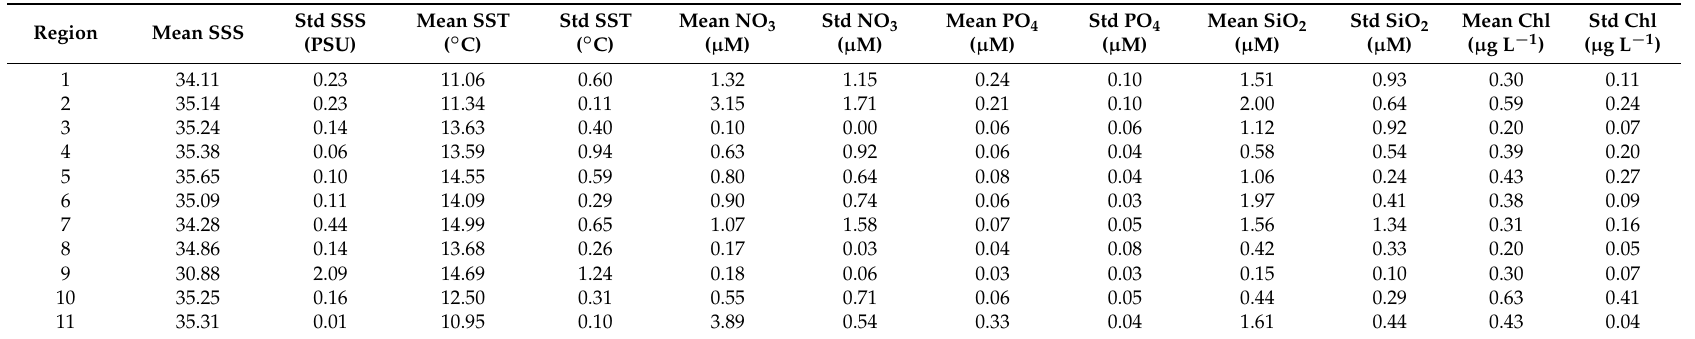
Table 1. Mean values and standard deviations (Std; 1 δ ) of S, T, TON, SiO4 and Chl per regions. Irish Sea (region 1), Malin Sea; northwest of Ireland (region 2),